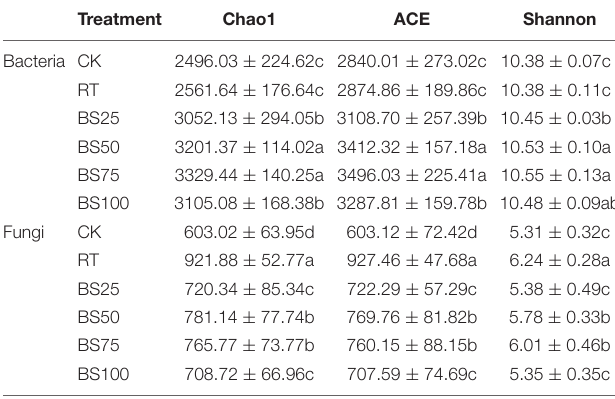
TABLE 3 | Richness and diversity indices of bacteria and fungi in different treatments.